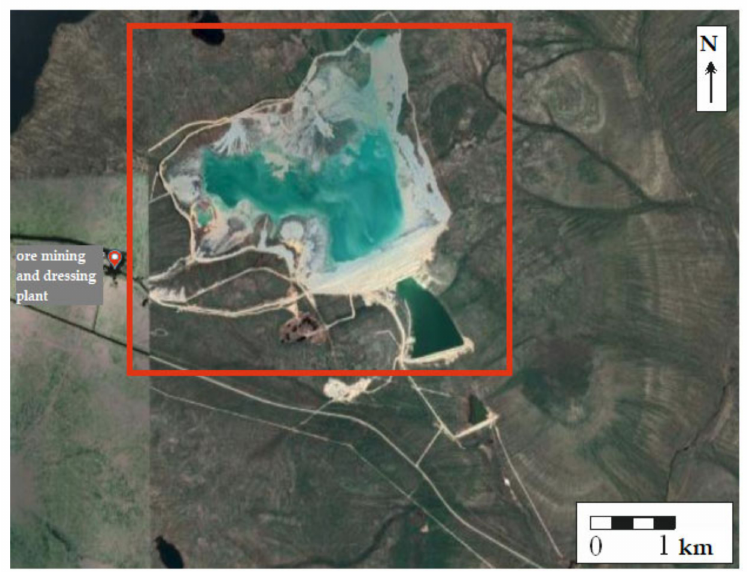
Figure 1. Satellite image of the study area (the tailings dump is highlighted in a red frame). Geomorphologically, the territory of the tailing dump is located in the trough-shaped valley of the Fossil Creek. The absolute elevations of the surface vary on the starboard side from 602.24 to 503.05 m. On the left side, they vary from 609.52 to 503.05 m. The elevation difference was 99.19 and 106.47 m, respectively